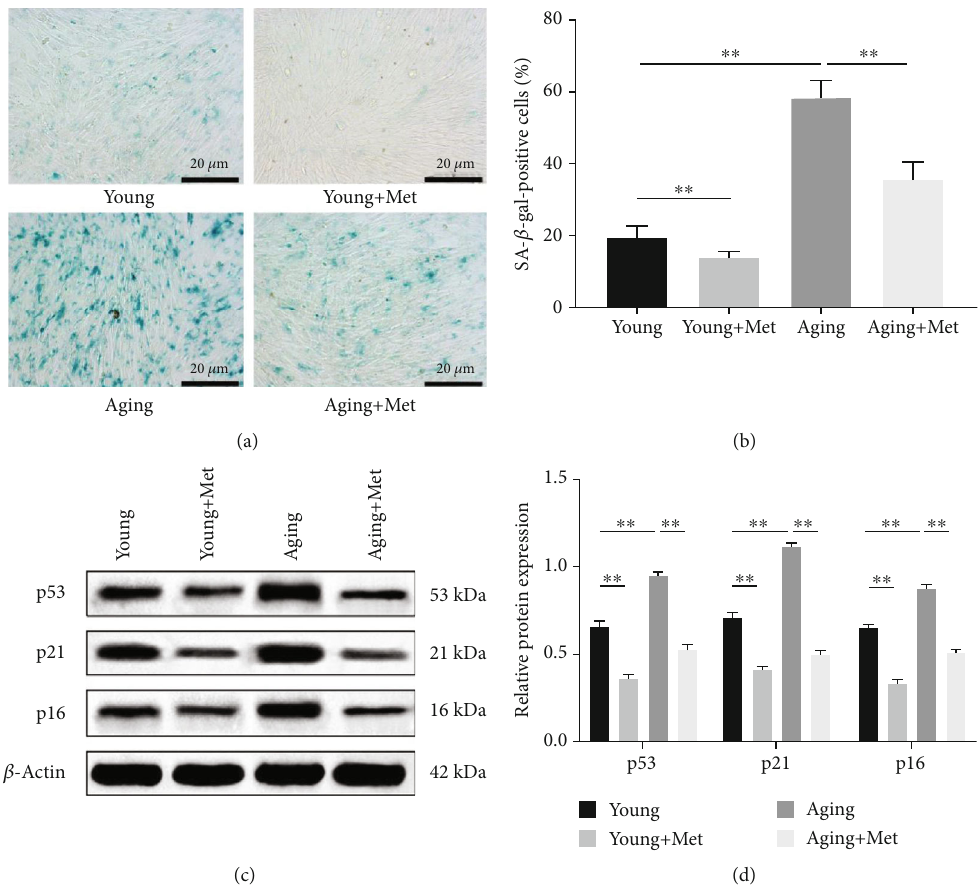
Figure 3: Metformin inhibits senescence in DPSCs. Young and aging DPSCs were treated with 100 μ M metformin for 48 h. (a) Cellular senescence was determined using SA- β -gal staining. Representative images are shown (scale bar: 20 μ m). (b) Quantitative analysis of SA- β -gal-positive cells. (c) Representative blots of p53, p21, and p16 protein expression levels by western blotting. (d) Quantitative analysis of p53, p21, and p16 proteins. Data are expressed as the mean ± standard deviation ( n = 3 ). ∗∗ p < 0 : 01 , with comparisons indicated by